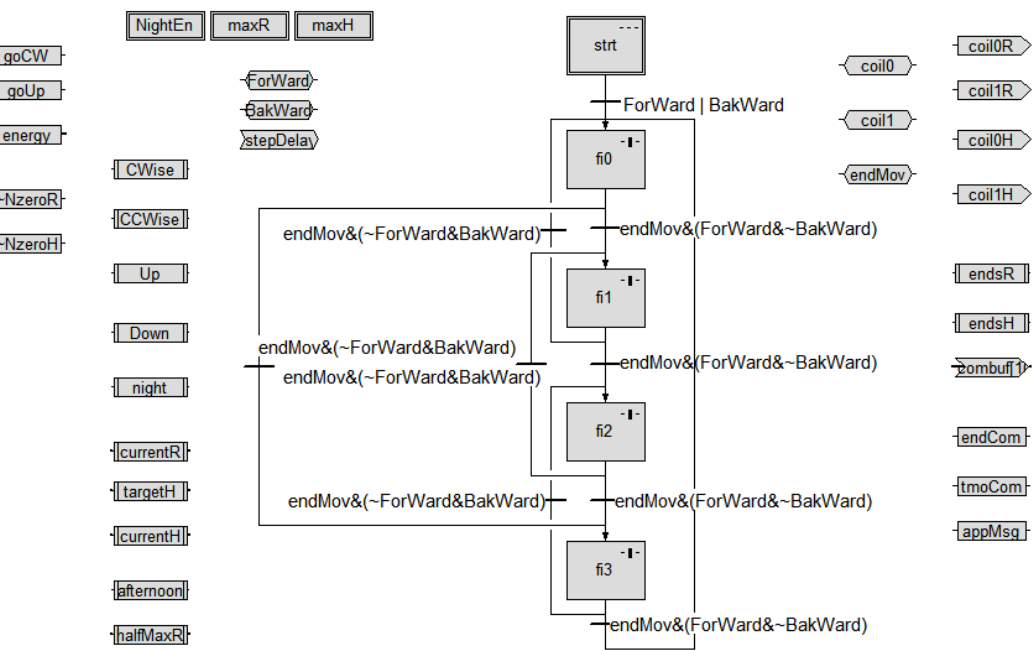
Figure 4. An example of Control Flow.